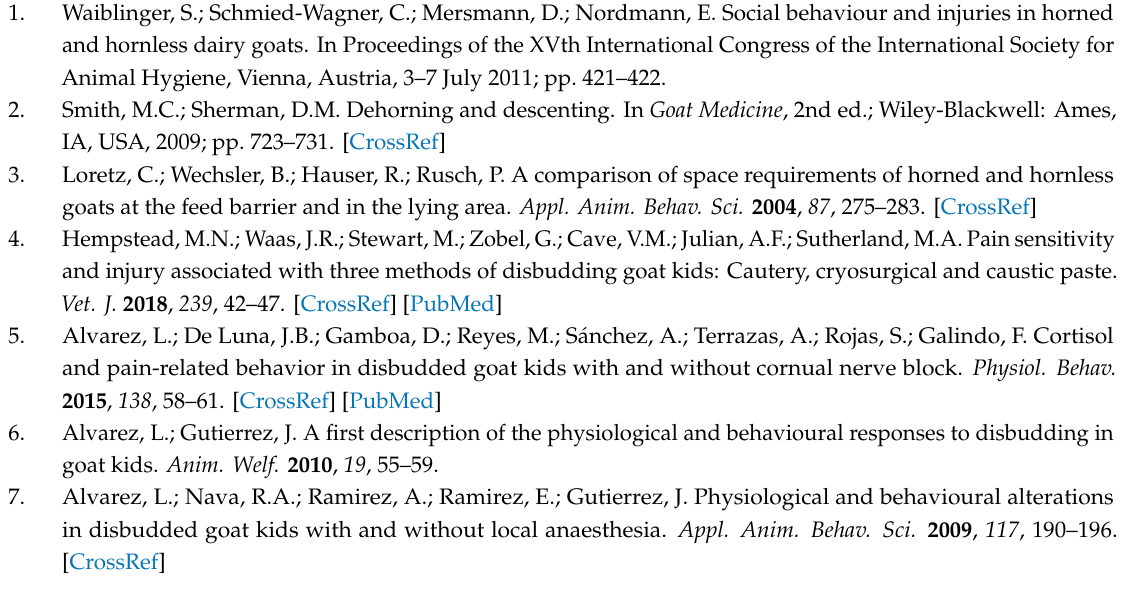
Table S1: Data set used in the present